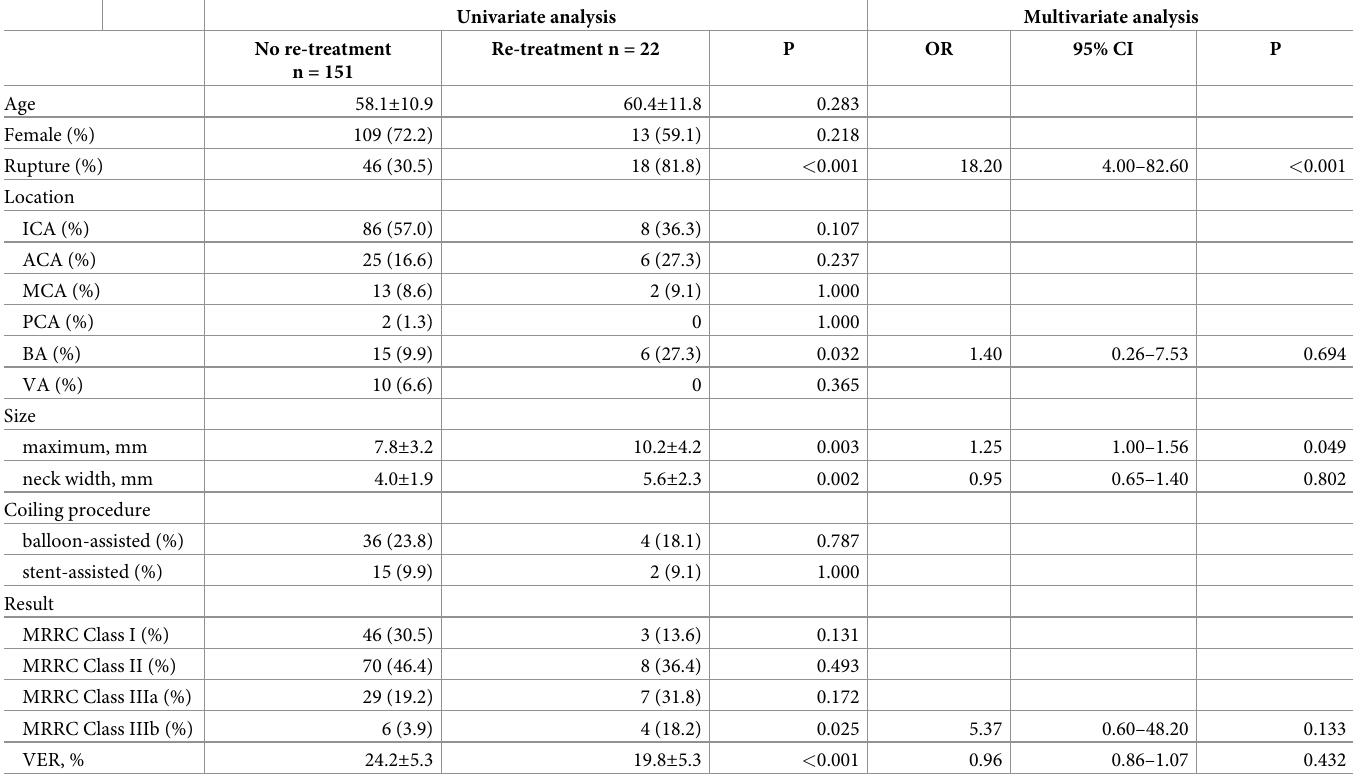
Table 2. Factors associated with re-treatment after coil embolization. Univariate analysis Multivariate